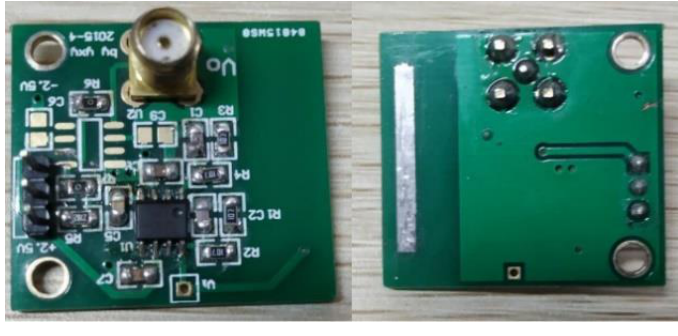
Figure 11. Sensor board.